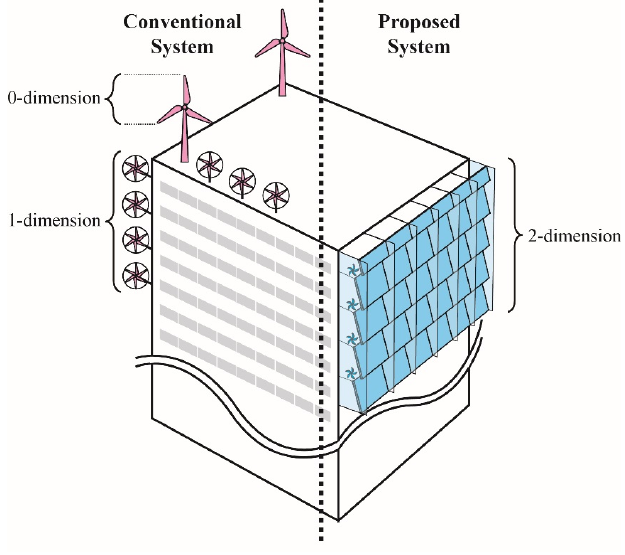
Figure 3. Comparison of the installation area between the proposed system and the conventional